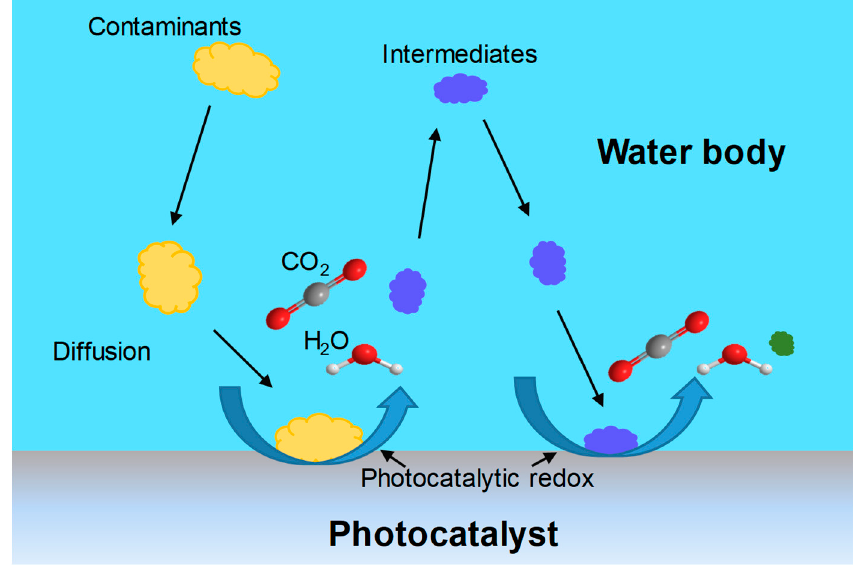
Figure 2. Schematic diagram demonstrating the removal of contaminants in water with the presence of photocatalysts [18,29,30].